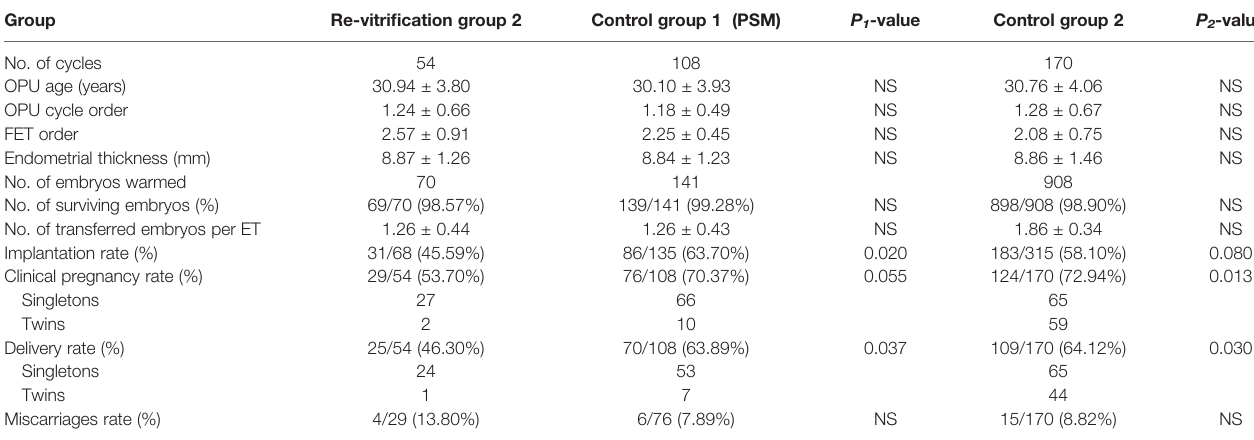
TABLE 2 | Clinical parameters and outcomes of blastocyst transfers with once- or twice-vitri fi ed-warmed embryos.